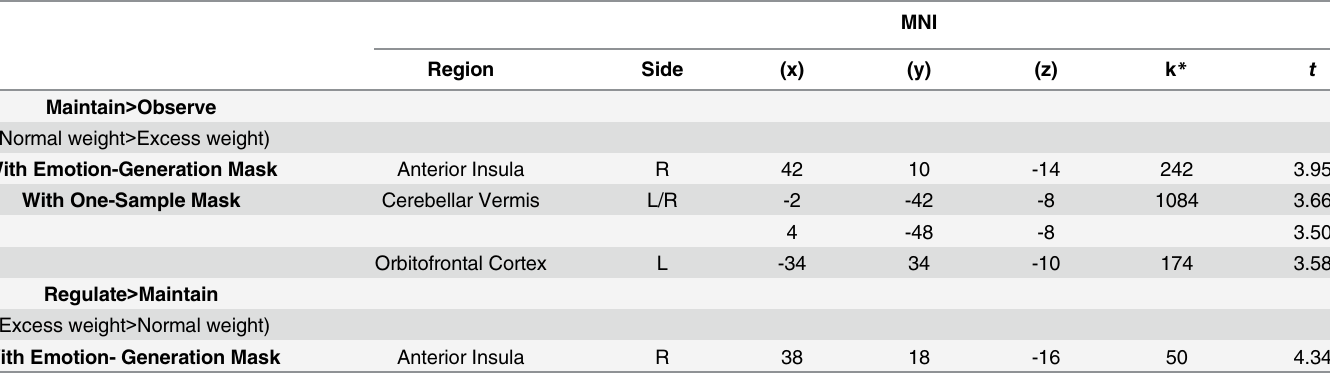
Table 3. Neuroimaging